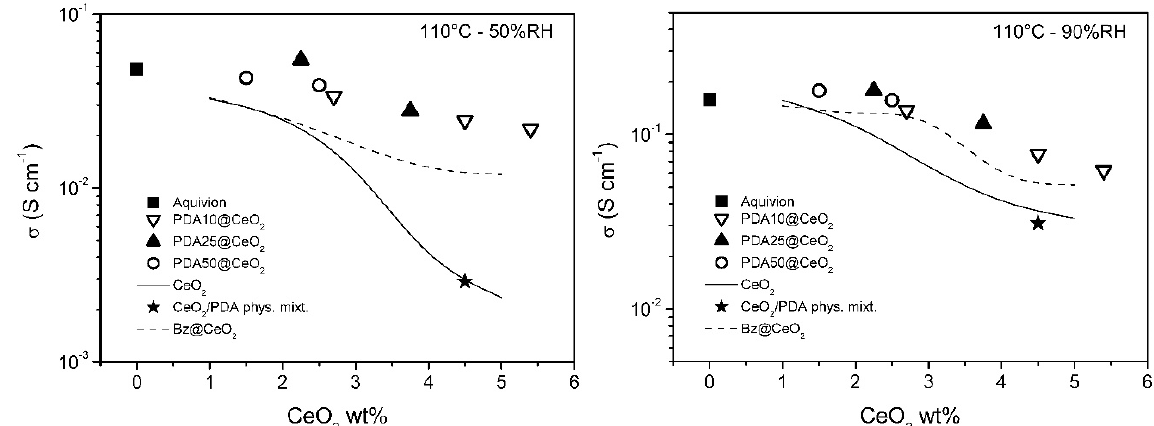
Figure 9. Conductivity as a function of CeO 2 loading, at 110 °C, for composite Aquivion membranes filled with PDAx@CeO 2 (x = 10, 25 and 50), as well as with the physical mixture PDA/CeO 2 (see text). The conductivity of composite Aquivion membranes containing bare CeO 2 and Bz@CeO 2 (redrawn from ref. [16]) is reported for comparison.